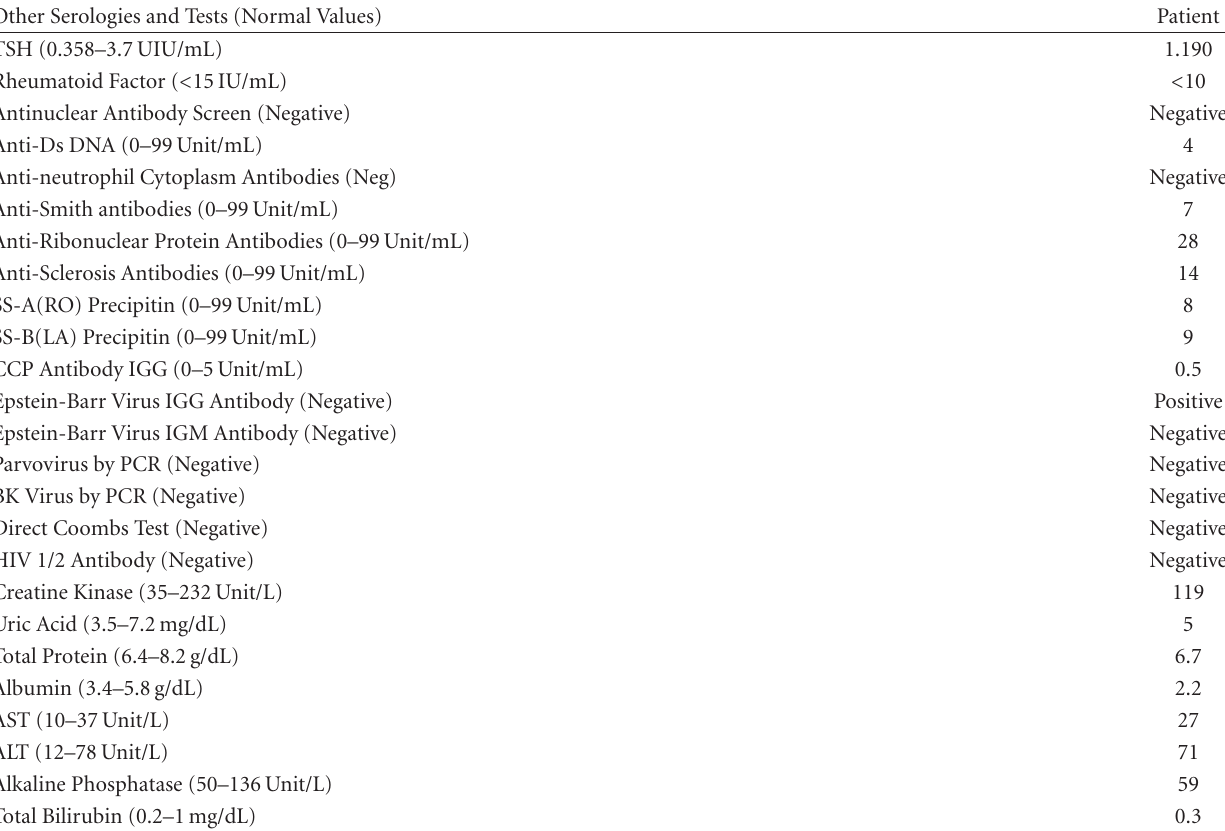
Table 3: Serological and specific laboratory